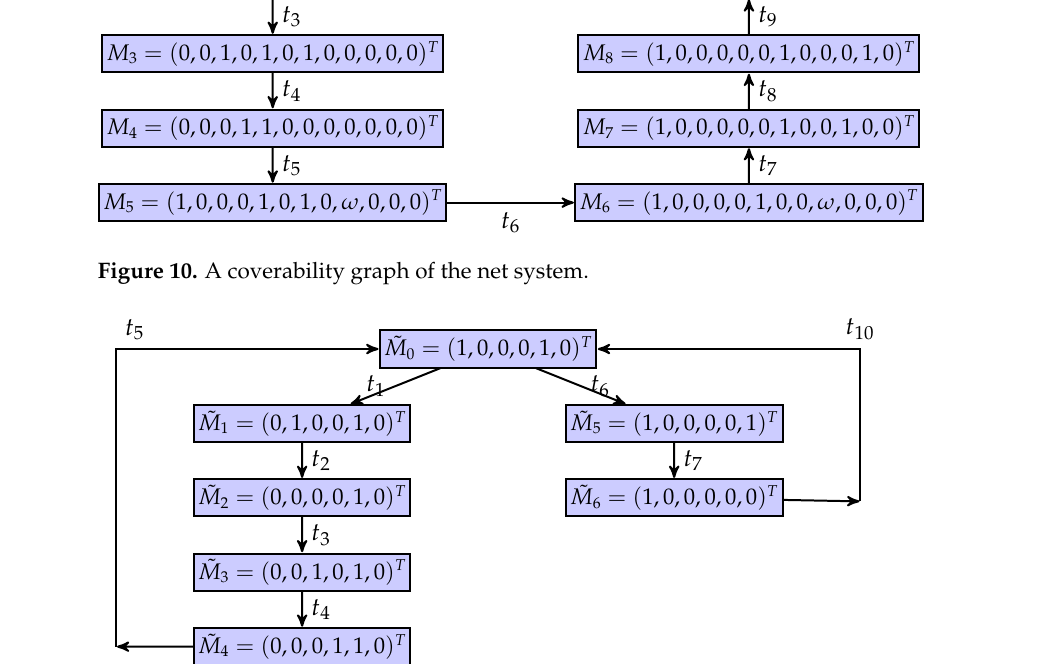
Figure 11. A BCG of the net